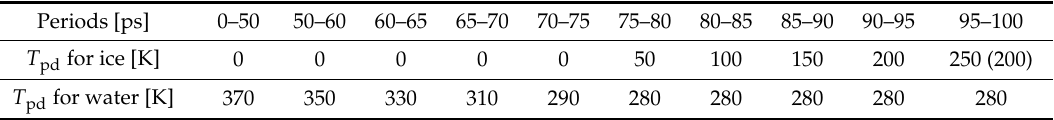
Predetermined temperatures for producing the mixture of water an ice layer with pyramidal